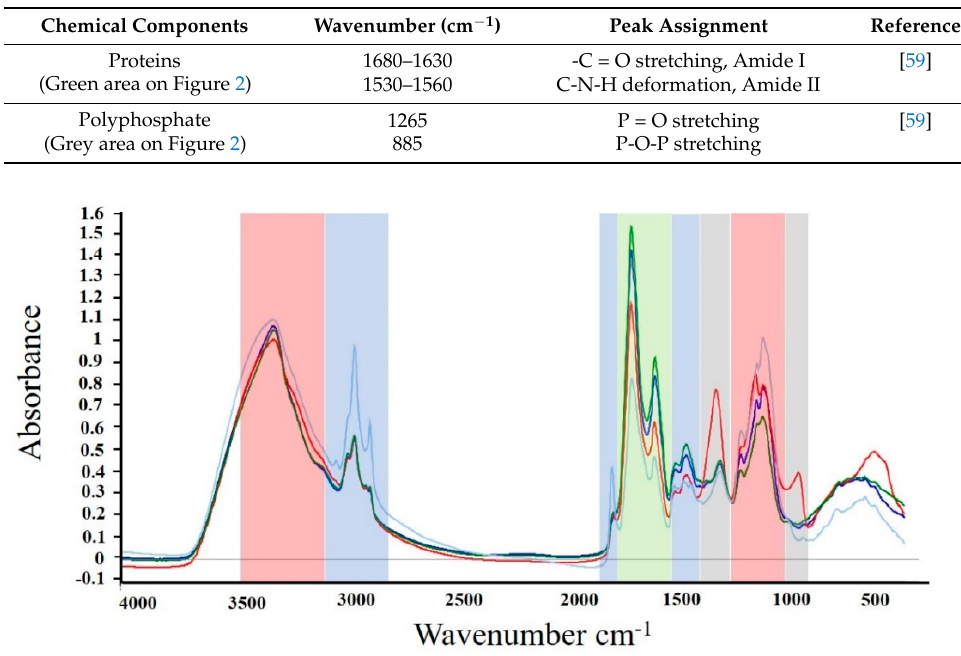
Figure 2. Preprocessed FTIR-HTS spectra of Chlorella vulgaris grown for 94 h on control medium (dark blue), nitrogen starvation (light blue), phosphorus starvation (green) and sulphur starvation (red) under light intensity 1800 µmol m − 2 s − 1 in experiment 1.